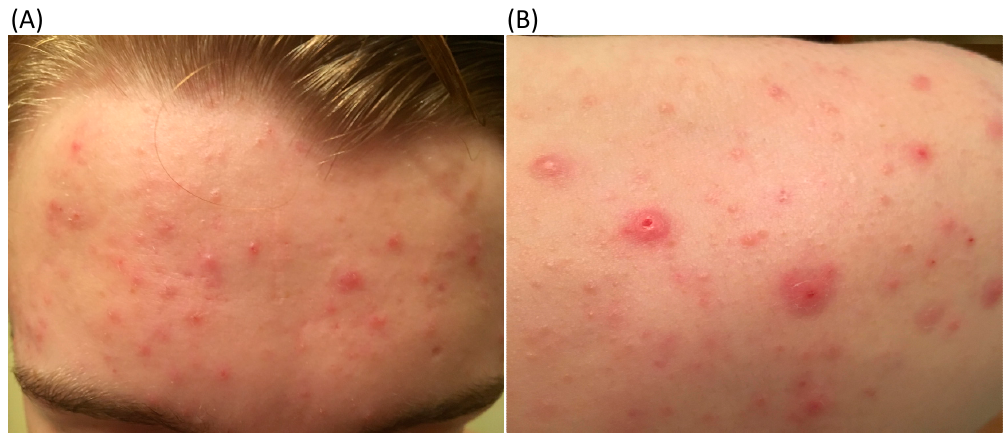
Figure 1. Moderate inflammatory and non-inflammatory acne lesions on the forehead ( A ) and shoulder ( B ) of a 14-year-old adolescent